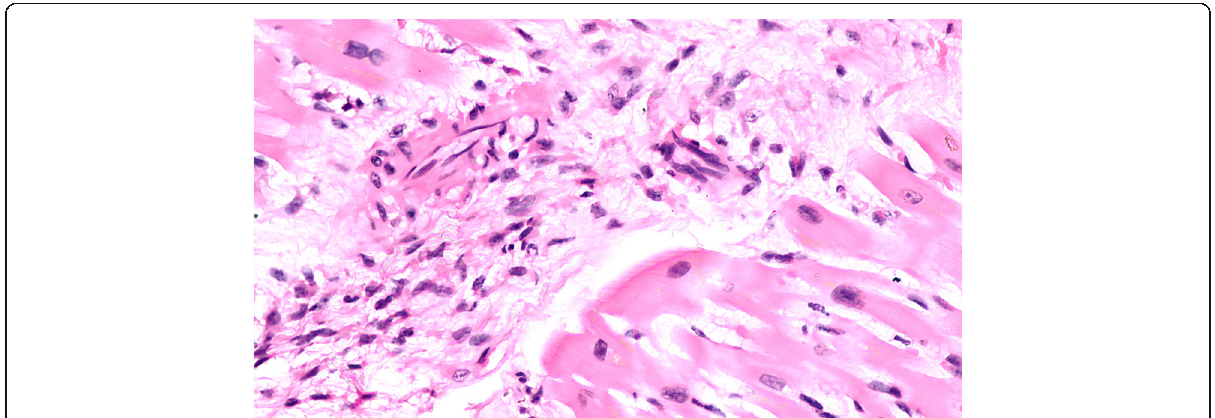
Fig. 4 Microphotograph of myocardial tissue showing myocarditis. There is an inflammatory infiltrate involving myocardial fibres with myocytolysis (H&E,